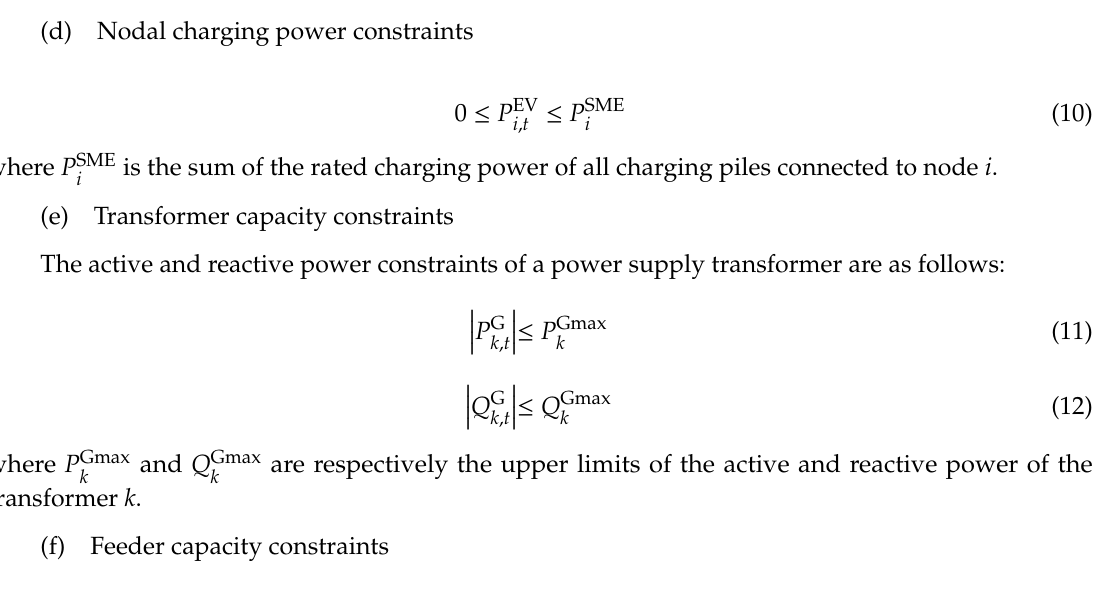
Figure 2. Two typical wiring modes: ( a ) power supply from sources; ( b ) power supply from a single source.